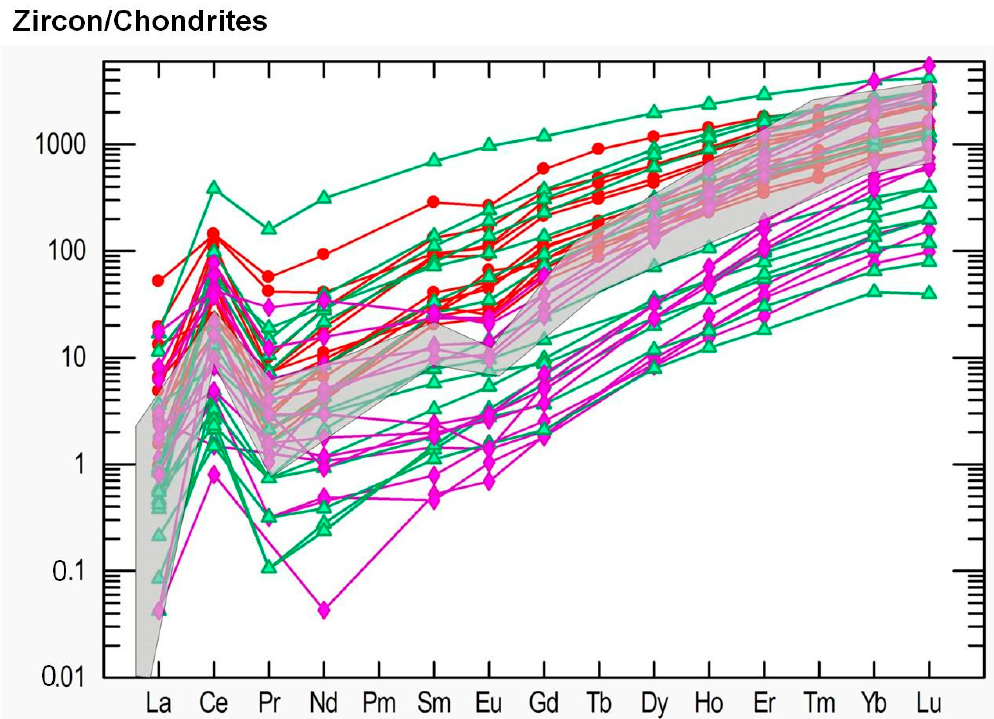
Figure 14. Chondrite-normalized concentration of REE in studied zircons from kyshtymites (samples 8-K—bold red circles), miascites (bold purple diamonds), and carbonatites (bold green triangles) of the Ilmenogorsky-Vishnevogorsky complex modified after (REE data on miascites and carbonatites are after [45]). Data on REE in chondrite are after [41]. Grey area is common REE distribution in magmatic zircons by Belousova et al. (2002) [43].